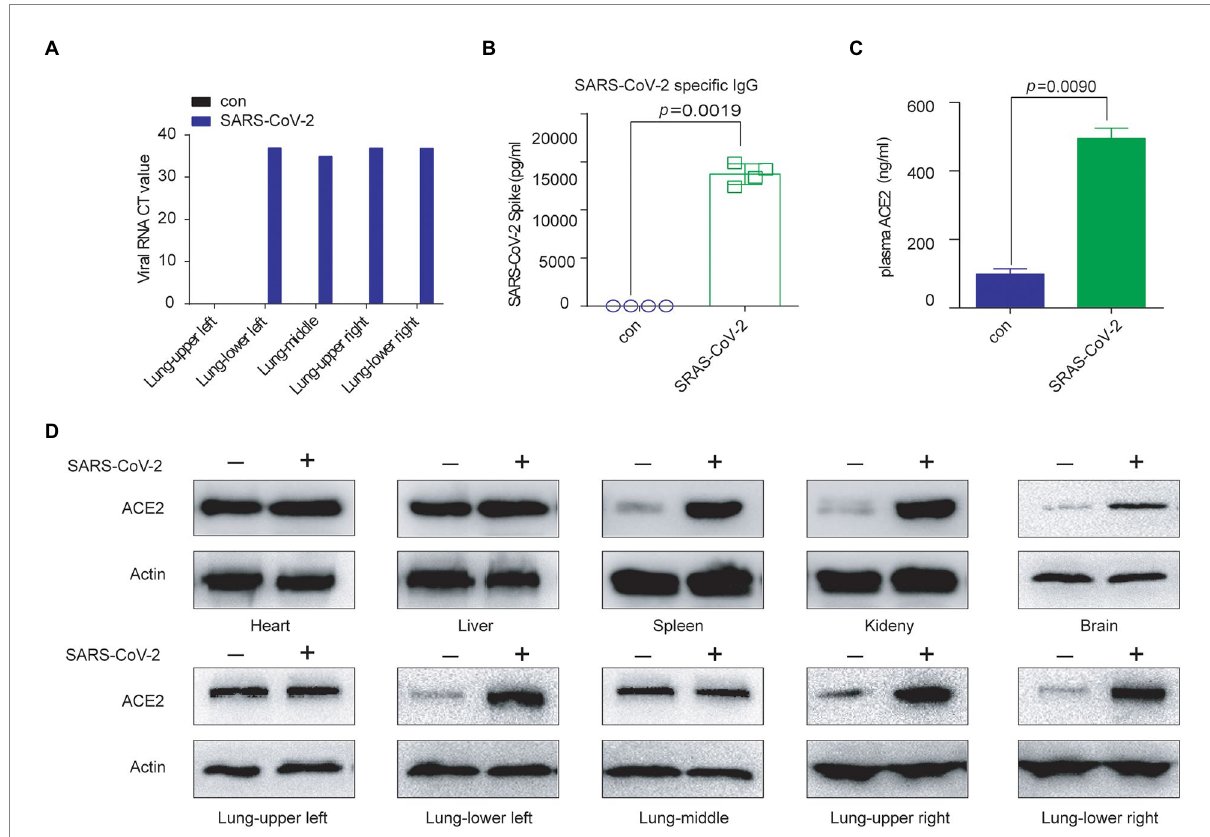
FIGURE 1 SARS-CoV-2 exposure resulted in elevated ACE2. (A) The SARS-CoV-2 RNA level was increased in the mouse lung (except the upper-left part) by inactivated virus treatment. (B) SARS-CoV-2–specific neutralizing antibody levels were increased in BALB/c mice treated with inactivated virus, as detected by ELISA. (C) The ACE2 protein level was increased in BALB/c plasma by inactivated virus treatment, as detected by ELISA. (D) The expression of ACE2 protein was significantly upregulated in the main organs by inactivated SARS-CoV-2 treatment, except in the middle and upper-left